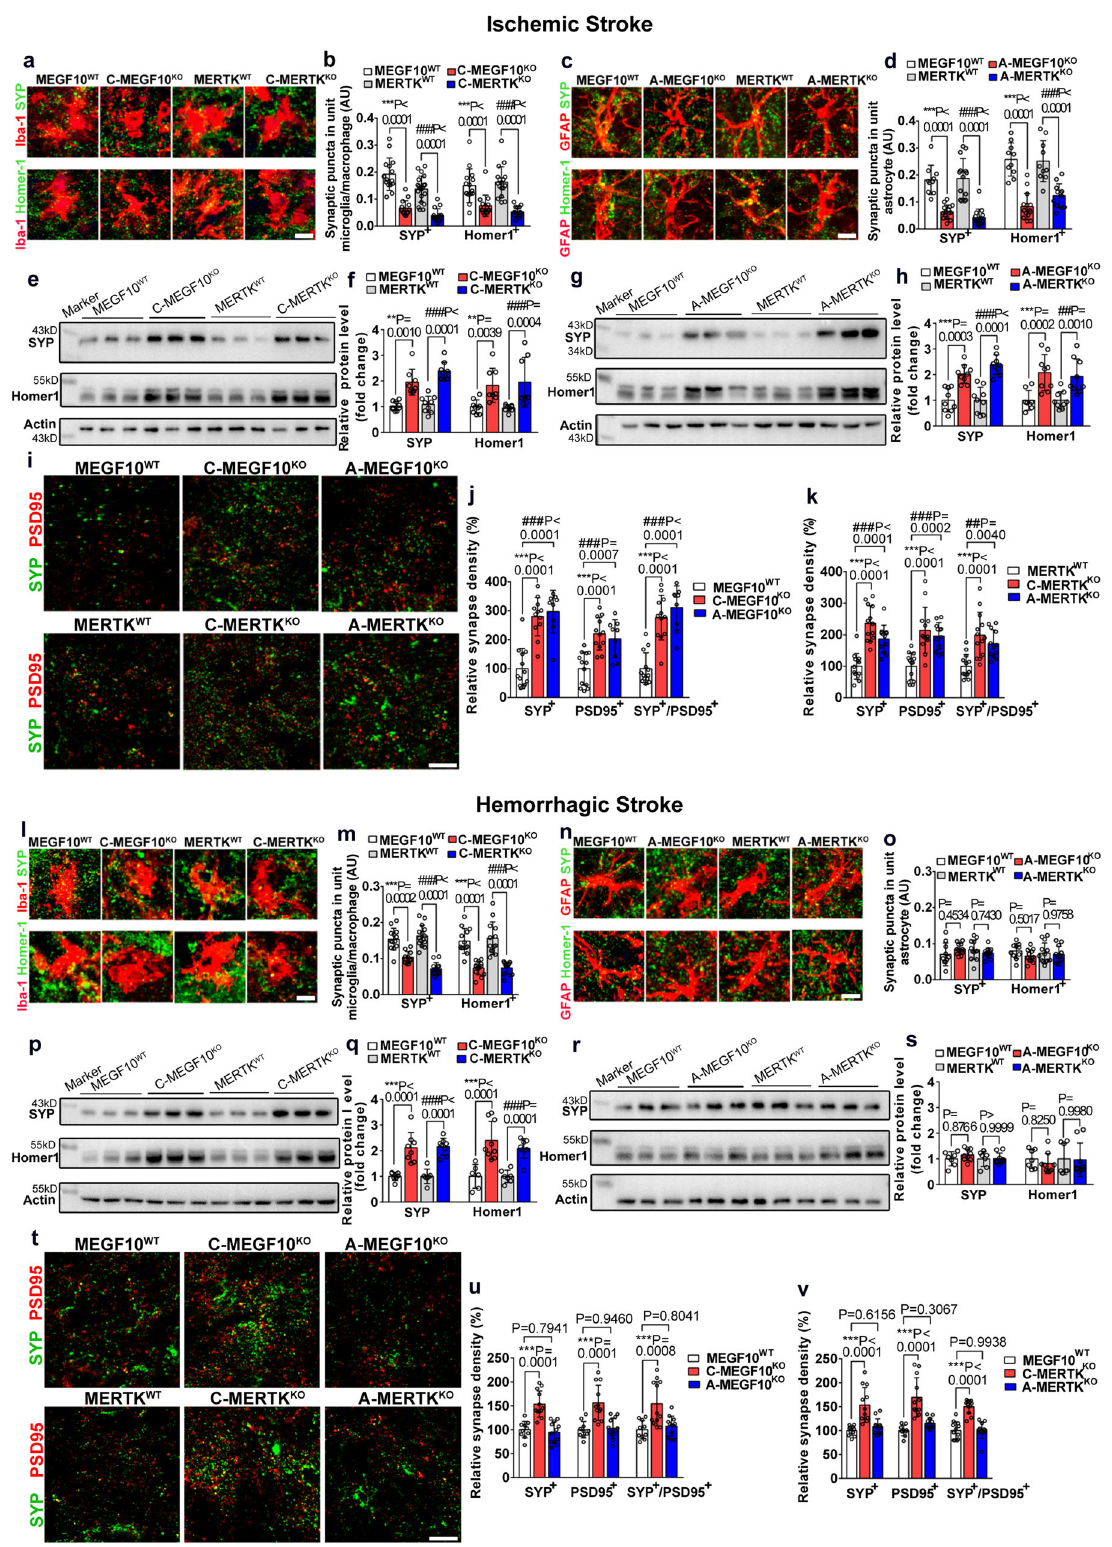
astrocytes played a critical role in engul fi ng dendritic spines via MEGF10 and MERTK after hemorrhagic stroke. Conditional MEGF10 or MERTK knockout in microglia/macro- phages or astrocytes differentially affected brain impairment